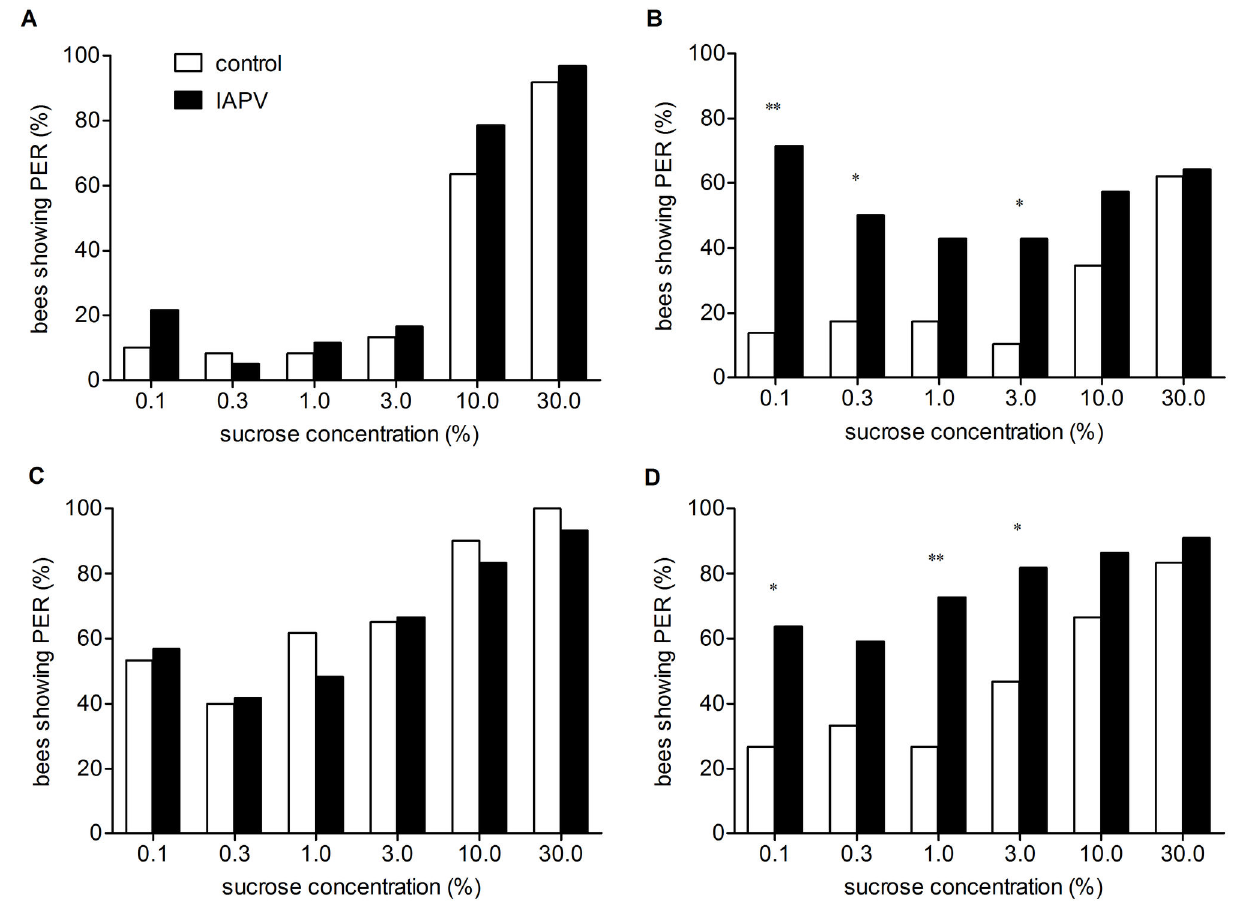
Figure 2. Comparisons between IAPV-injected honey bees and PBS-injected honey bees in their responsiveness to sucrose. Sucrose responsiveness of honey bees injected with IAPV with 1: 500 dilution and PBS-injected honey bees were tested at days 0 (A) and 3 (B) after injection. The number of honeybees tested at day 0 post-injection is 60 for each group; the number of honeybees tested at day 3 for IAPV-injected group is 14 and 29 for the PBS-injected group (*=p<0.05, **=p<0.01); sucrose responsiveness of honey bees injected with IAPV with 1: 200 dilution and PBS-injected honey bees tested at days 0 (C) and 2 (D) after injection. The number of honey bees tested at day 0 post-injection is 60 for each group; the number of honey bees tested at day 2 for IAPV-injected group is 22 and 30 for the PBS-injected group (*=p<0.05, **=p<0.01).